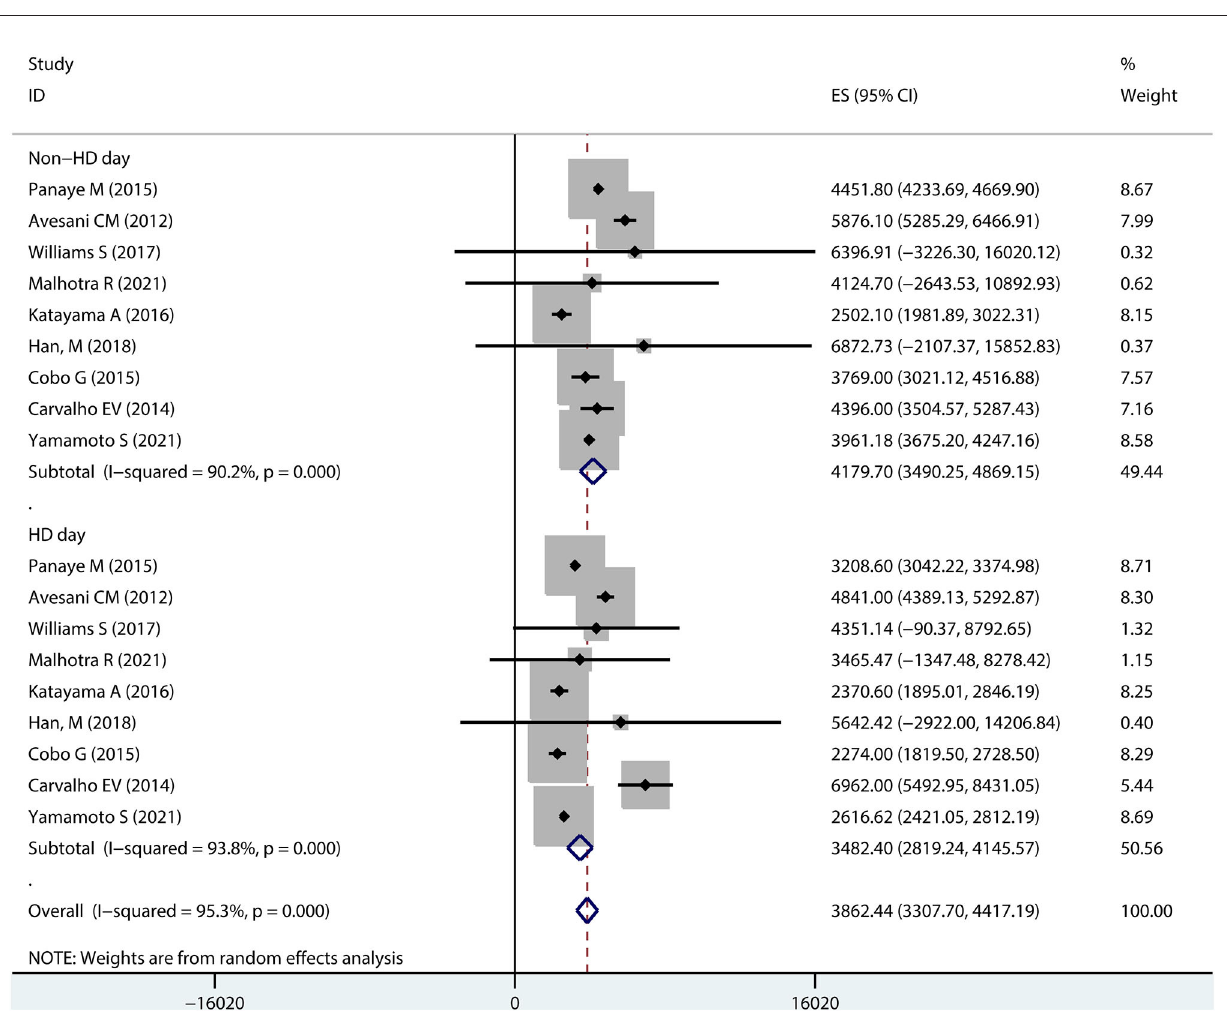
FIGURE 3 | Forest plot of the overall step counts by dialysis and non-dialysis